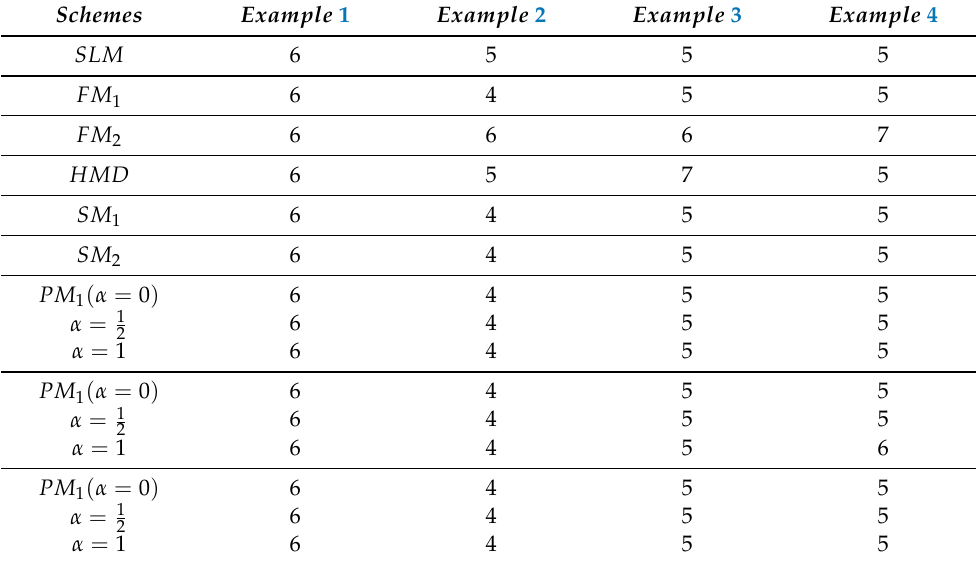
Table 5. Iterations comparison of different